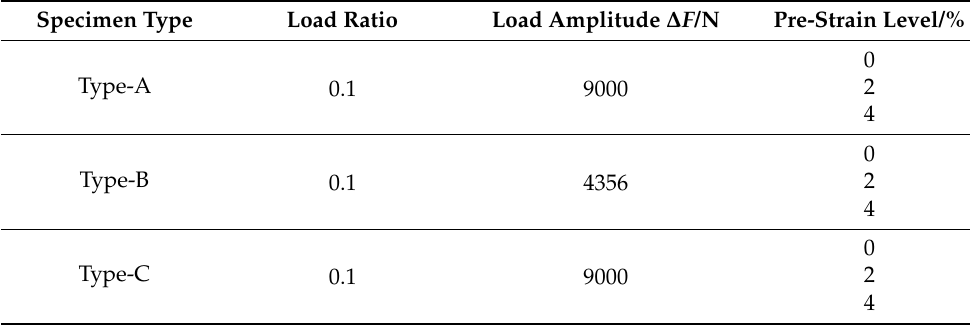
Table 2. Fatigue crack growth test scheme after